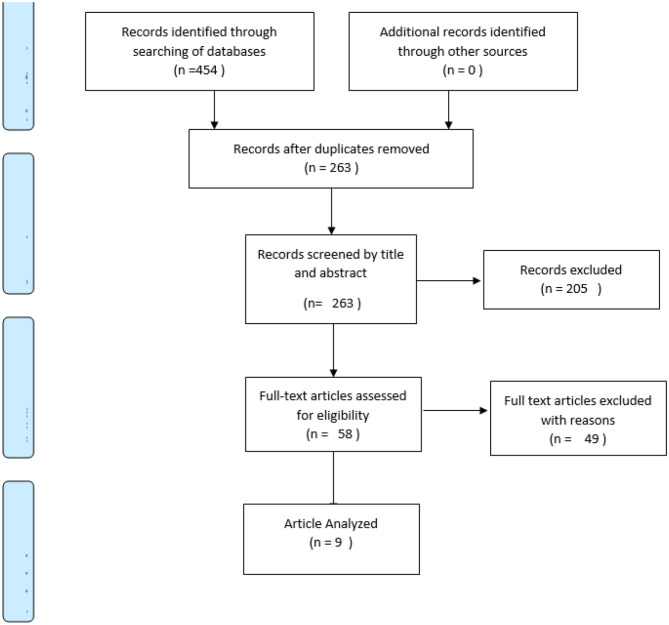
PRISMA flow diagram.